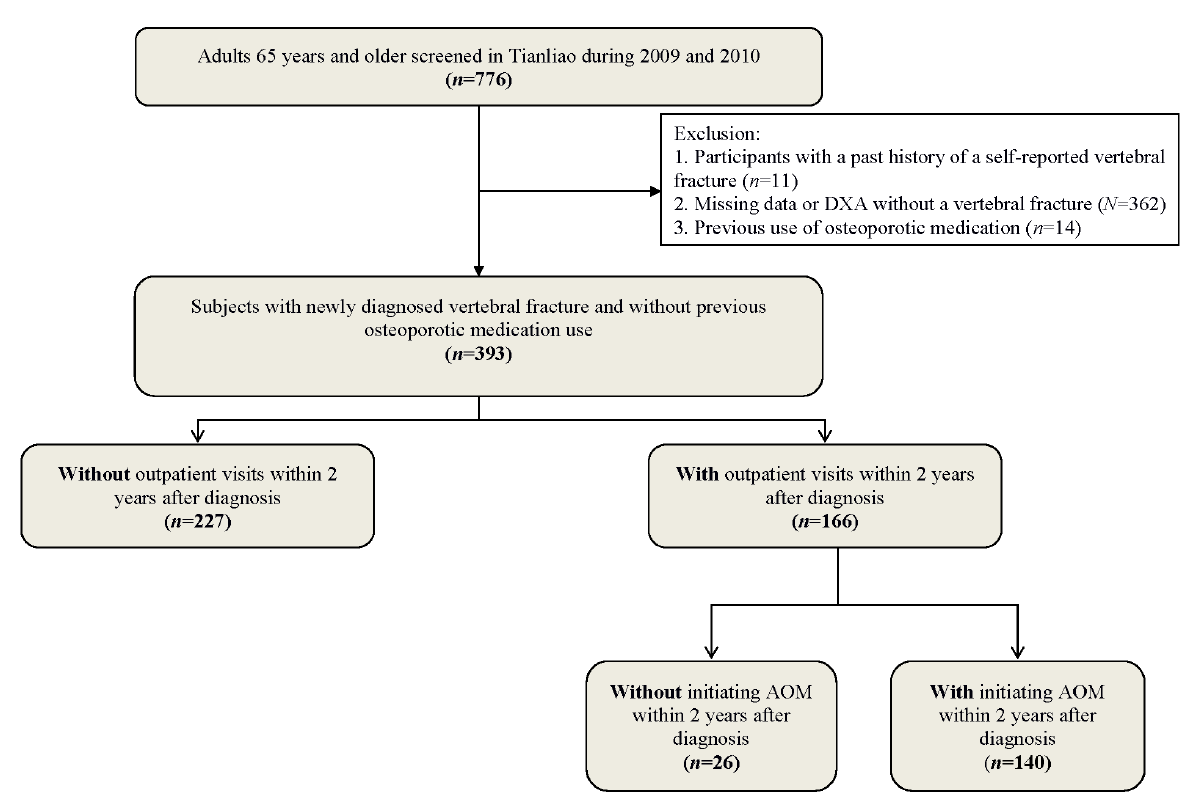
Figure 1. Flow chart of study design, n = 393.